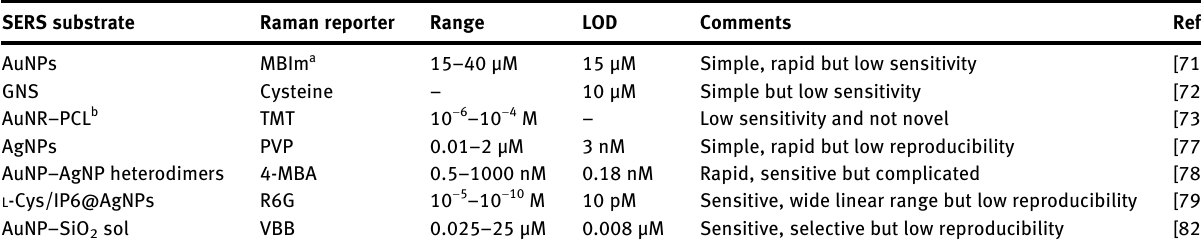
Table  : The assays of detection of copper ions based on the SERS method. SERS